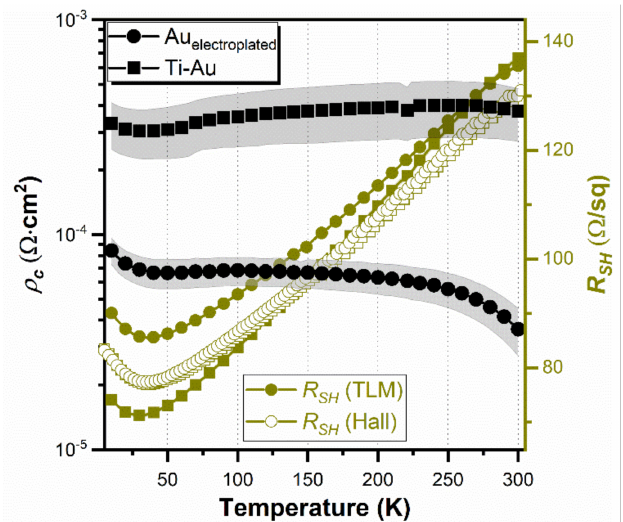
Figure 4. The temperature-dependent ρ c and R SH of electroplated Au and vacuum-deposited Ti– Au contacts to InAsSb. R SH derived from TLM (closed symbols) and Hall effect (open symbols) measurements are